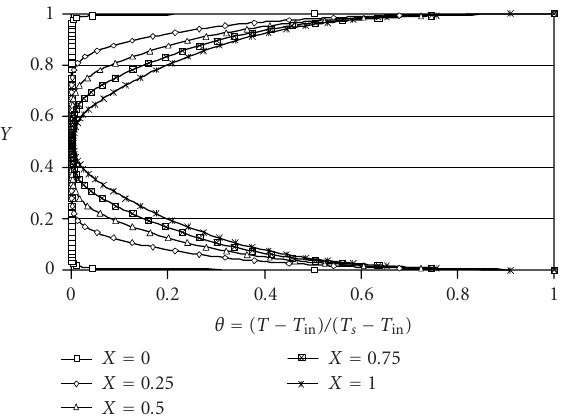
Figure 7: Nondimensional temperature distribution at di ff erent sections of the cooling channel for Re = 10000 and ˙ m r = 1 / 1.